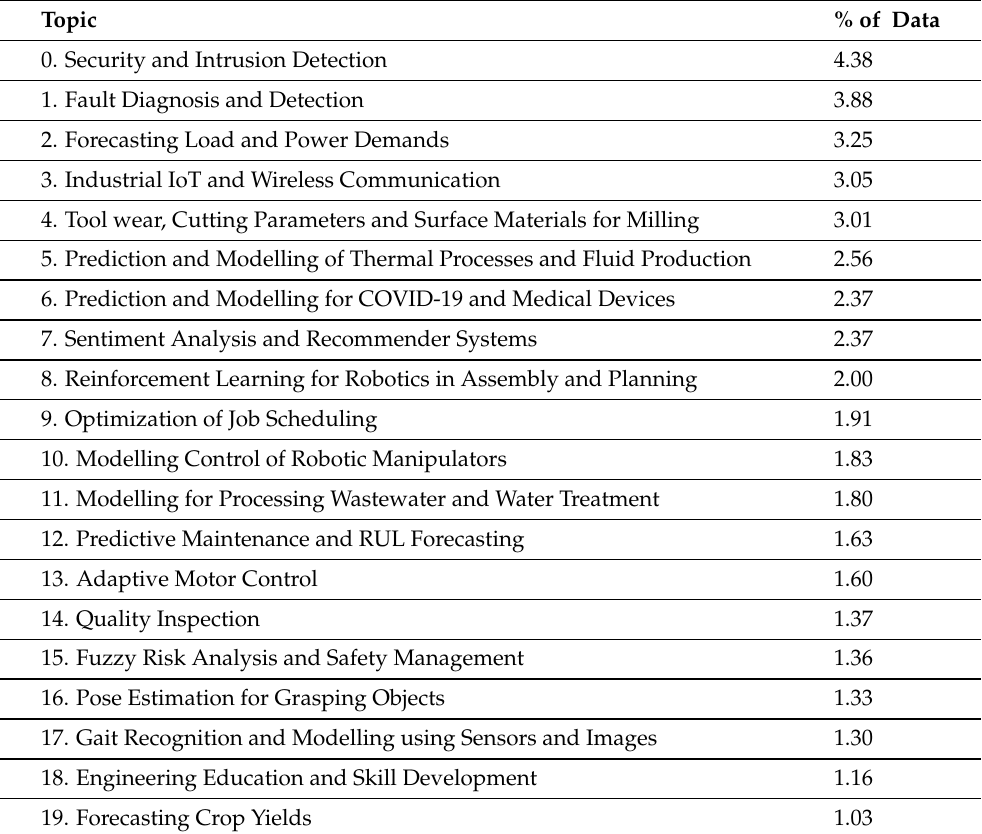
Table 3. Top 20 results of topic modelling inclusive of